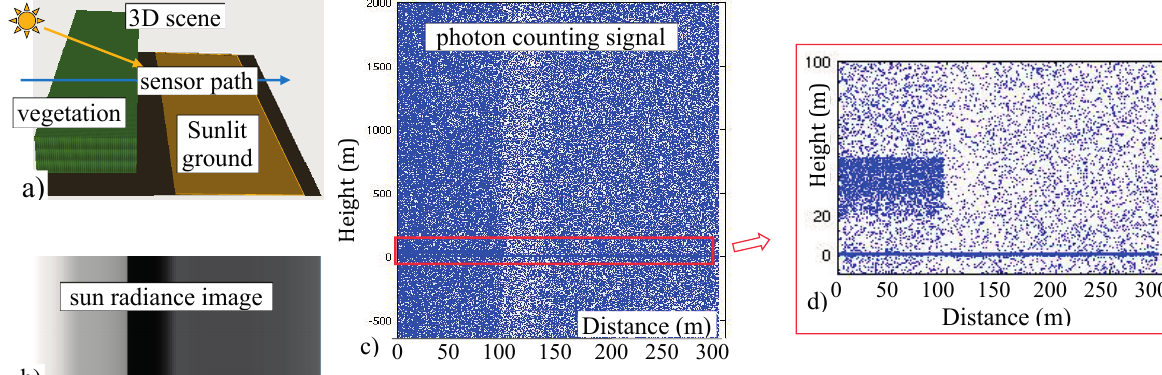
Figure 14. DART simulated photon counting LIDAR with solar noise. ( a ) Bare ground and vegetation plot with an oblique sun irradiation (  s = 45°) and a horizontal LIDAR sensor path. ( b ) Radiance image of the scene ( i.e. , solar noise). ( c ) Simulated photon counting signal. ( d ) An enlarged subset of simulated scene ( c